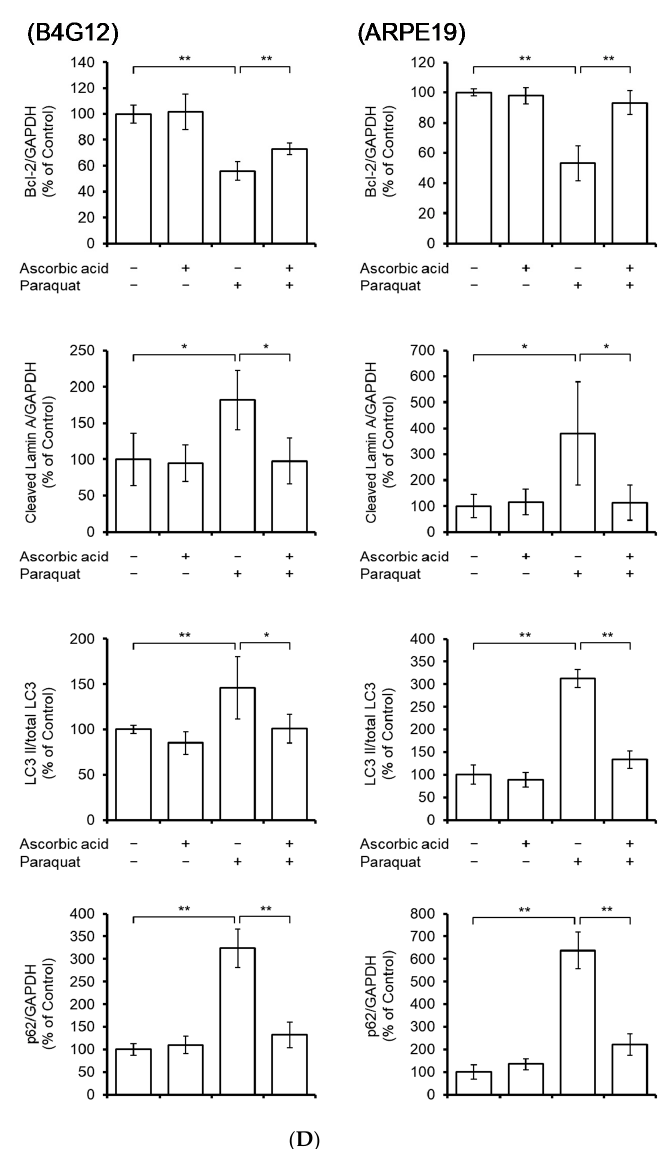
Figure 3. Pretreatment with ascorbic acid attenuates oxidative stress-induced apoptosis and autophagic flux blockage in B4G12 and ARPE-19 cells. B4G12 and ARPE-19 cells were cultivated in medium with or without 1 mM of ascorbic acid for two days, followed by the addition of paraquat (2 mM for ARPE-19 and 0.2 mM for B4G12) in the paraquat-treated groups (P only and C + P groups) for five days. ( A ) Paraquat-induced cellular accumulation of reactive oxygen species (ROS) and rescue by ascorbic acid was detected using ROS fluorescent dye (red color). ROS was induced by paraquat in both the B4G12 and ARPE-19 cells, and this was ameliorated by treatment with ascorbic acid. ( B ) Paraquat-induced apoptosis and rescue by ascorbic acid was examined using the TUNEL assay (green). ( C ) Paraquat-induced autophagosome formation and rescue by ascorbic acid was examined using immunofluorescence staining for LC3-II (autophagosome formation biomarker; green). ( D ) E ff ects of the paraquat and ascorbic on the protein expression of anti-apoptosis (Bcl-2), pro-apoptosis (lamin A, including cleaved forms), and autophagic flux (LC3 I / II and p62) biomarkers in B4G12 and ARPE-19 cells were probed using Western blotting. Paraquat induced altered protein expression in both B4G12 and ARPE-19 cells, and this could be reversed by ascorbic acid. The scale bars represent 100 µ m (A) and 50 µ m (B–C). Nuclei were counterstained with Hoechst 33342 (blue; B–D). ( n = 3, * p < 0.05, ** p <